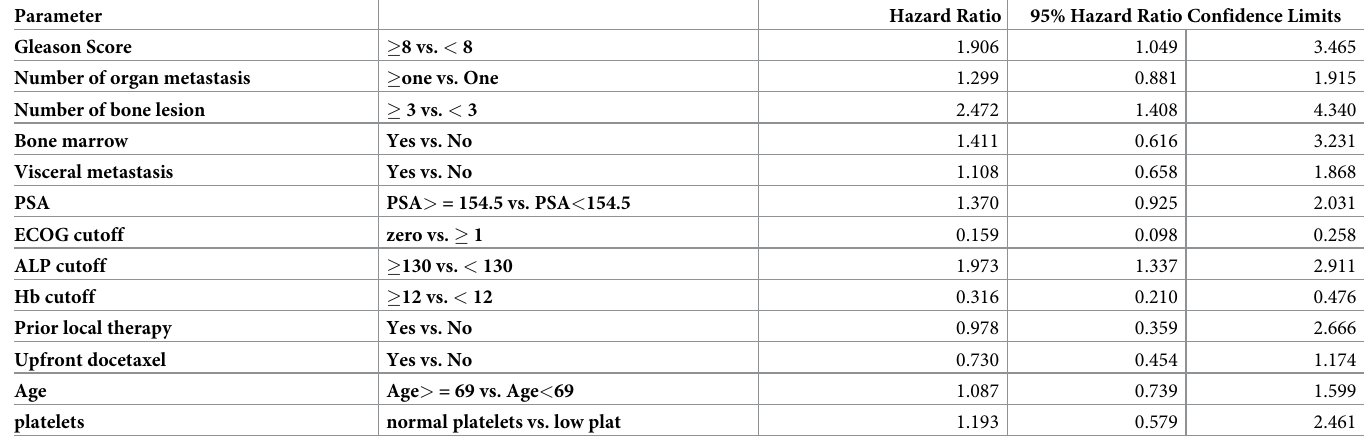
Table 3. Association between bone marrow involvement and overall survival on multivariate